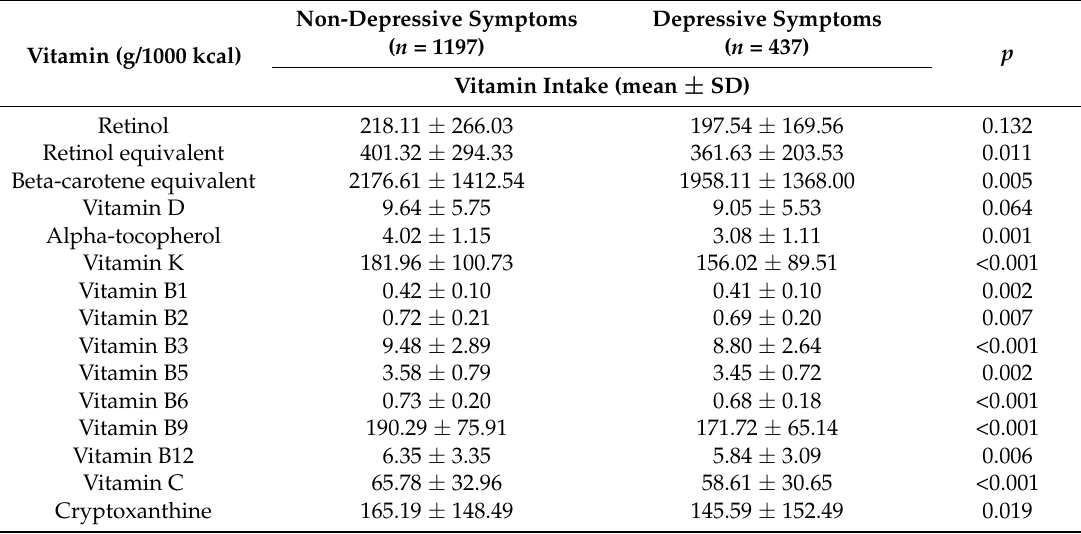
Table 2. Differences in vitamin intake between the groups with and without depressive